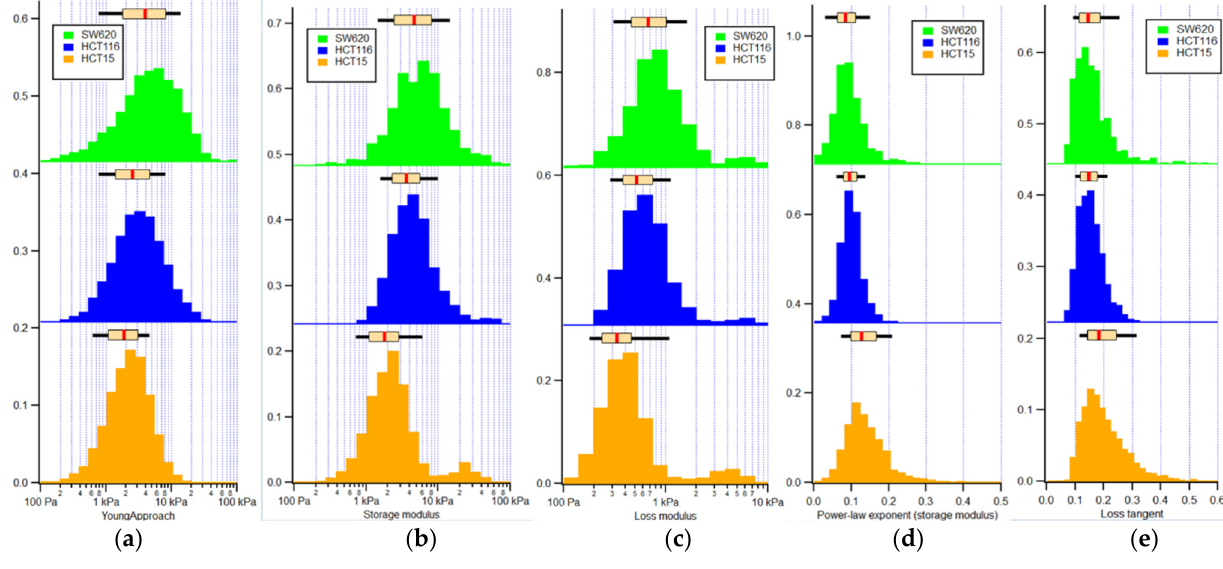
Figure 5. Histograms of mechanical properties quantification of the three CRC cell lines: ( a ) apparent Young’s modulus; ( b ) storage modulus; ( c ) loss modulus; ( d ) power-law exponent of the storage modulus; and ( e ) loss tangent. The boxplot above the histograms presents the median (red line) and the 25th and 75th percentiles (extent of rectangle in cream color), as well as the 10th and 90th percentiles (black lines extending beyond the box), respectively. Orange: HCT15, blue: HCT116, and green: SW620 cells.